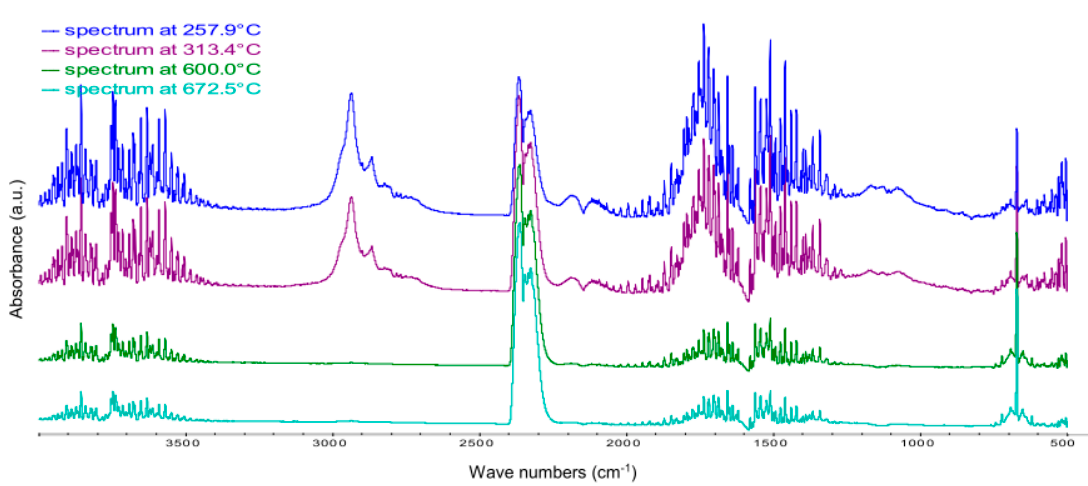
Figure 5. FTIR spectra of gases emitted during oxidative degradation of C15A recorded at: 257.9 °C (19.2 min), 313.4 °C (21.9 min), 600.0 °C (36.1 min) and 672.5 °C (39.7 min).